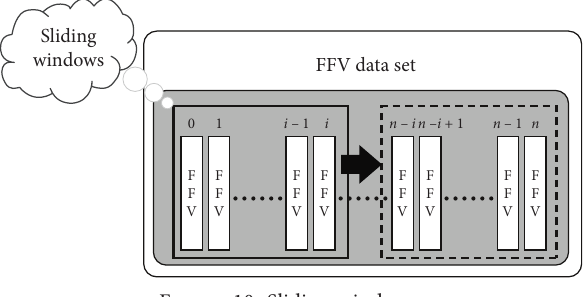
Figure 10: Sliding windows.